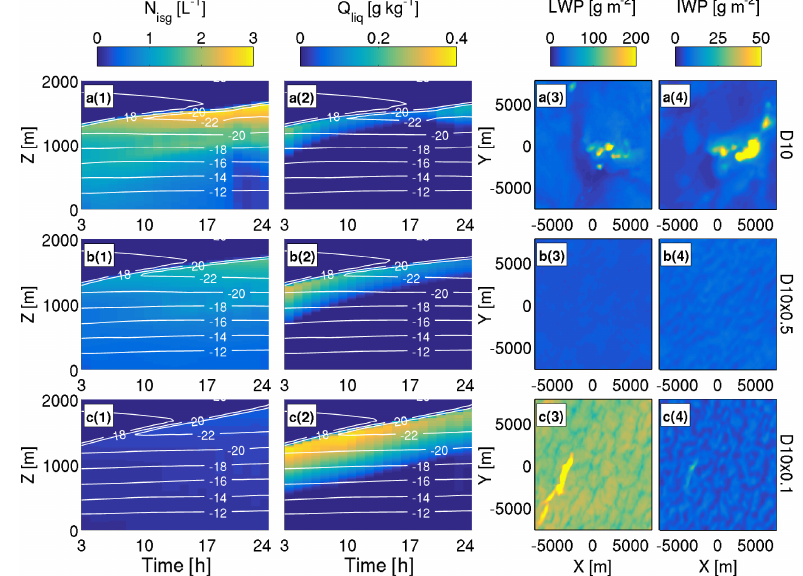
Figure 13. N isg (a1–c1) , Q liq (a2–c2) , LWP (a3–c3) , and IWP (a4–c4) modelled in the (a) D10, (b) D10 × 0.5, and (c) D10 × 0.1 simulations over the ocean (case 3). Data are presented similarly to Figs. 10 and 11. Temperature ( ◦ C) contours overlaid in white in panels 1 and 2. Note changing colour bar at the top of each column, which corresponds to data in that column